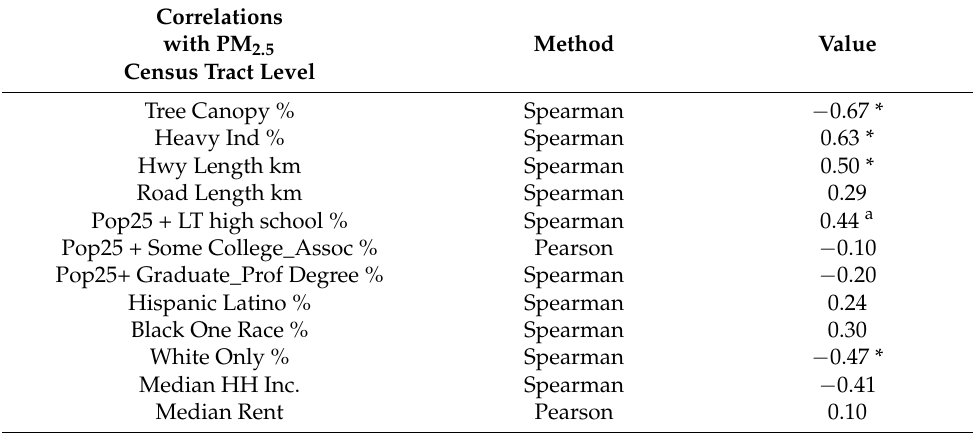
Table 7. Correlations of average PM 2.5 at the census tract